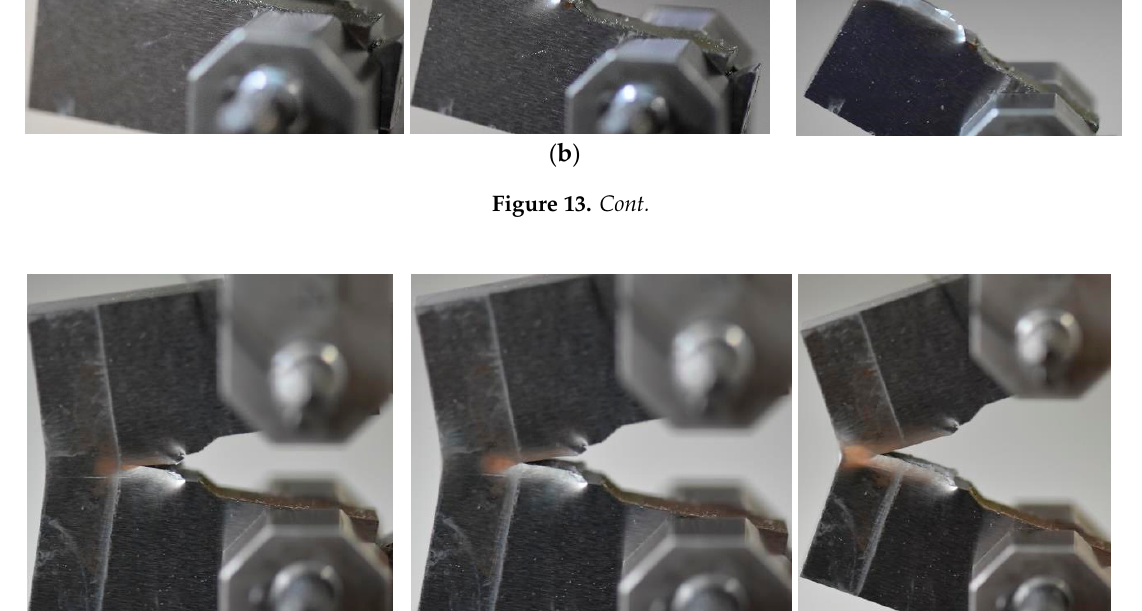
Figure 13. CT mini-specimens at the final stage of CTOD tests: ( a ) parent material; ( b ) HAZ; ( c ) weld.